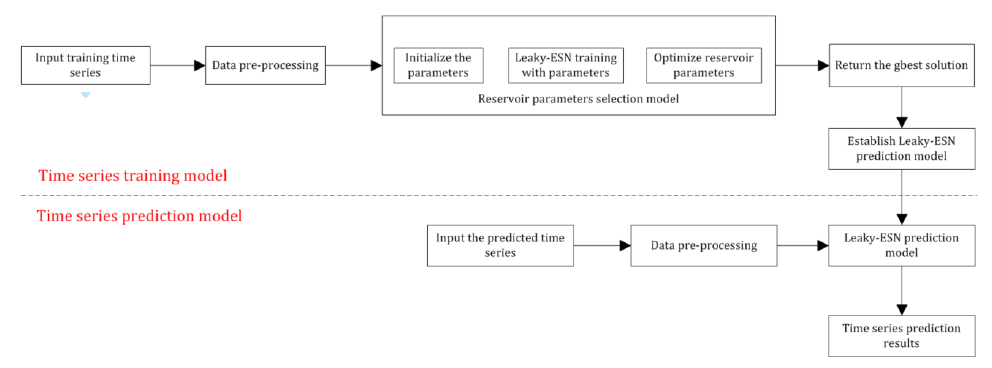
Figure 10. The overall framework for time series prediction in the